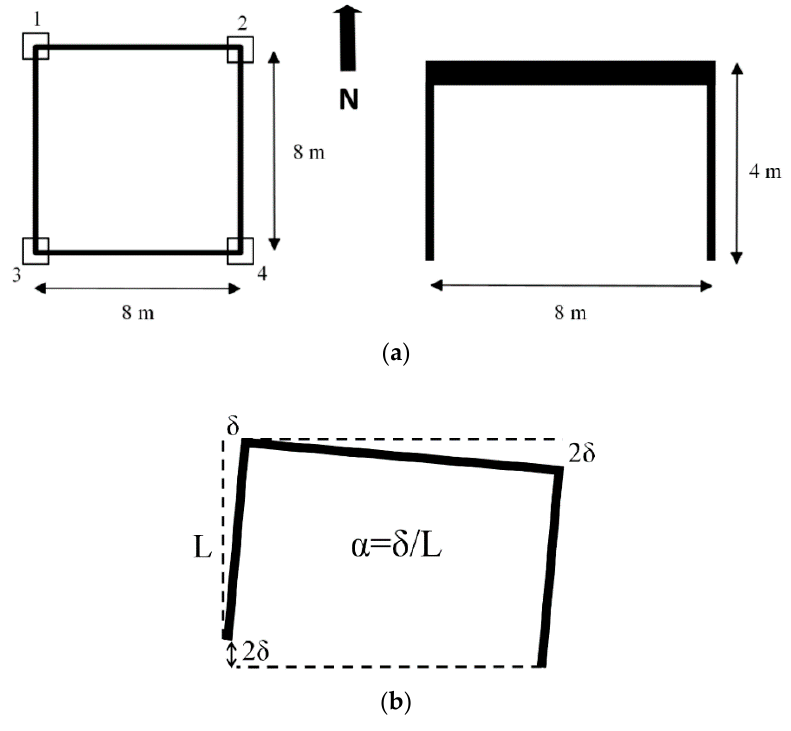
Figure 4. ( a ) plan and elevation, and ( b ) definition of the parameter α of the simplified structural systems used in this study.